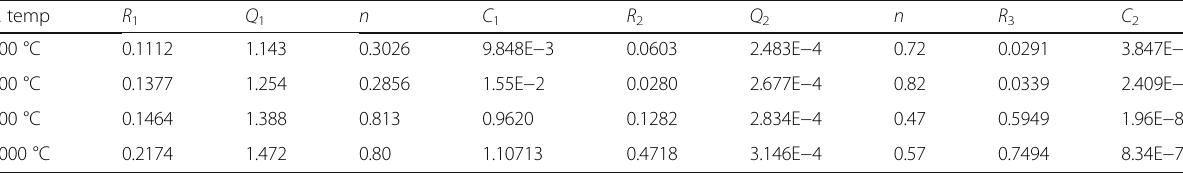
Table 1 The fitting results of impedance spectra using the R 1 ( R 2 Q 2 )( R 3 Q 3 ) equivalent circuit. Resistance ( R ); Q has a unit of F cm − 2 S.